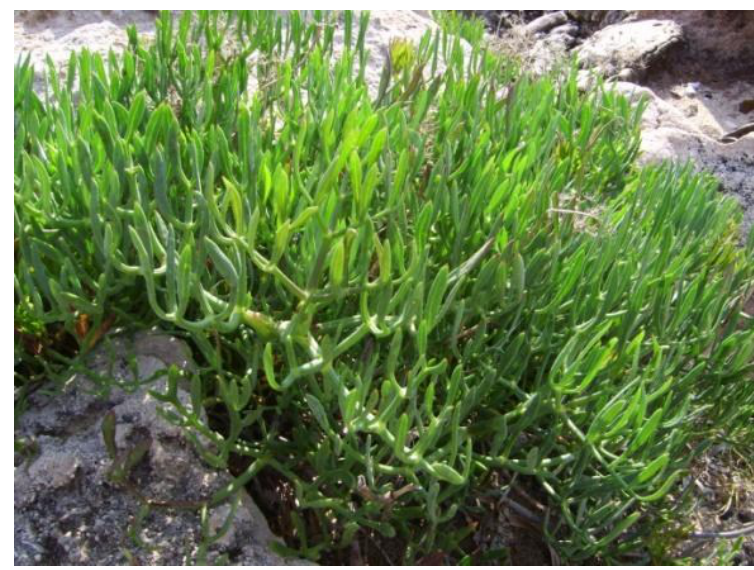
Figure 11. Plant of sea fennel on a rock-sandy beach as typical example of natural habitat for this halophyte.